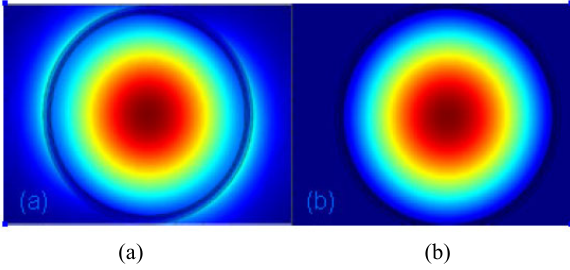
Fig. 2 Electric field distribution in the cross section of the fiber microring at the wavelength  =460 nm: (a) when the SPR is excited with the gold film thickness of 50 nm and analyte RI is 1.33 and (b) no SPR is excited in the absence of the gold